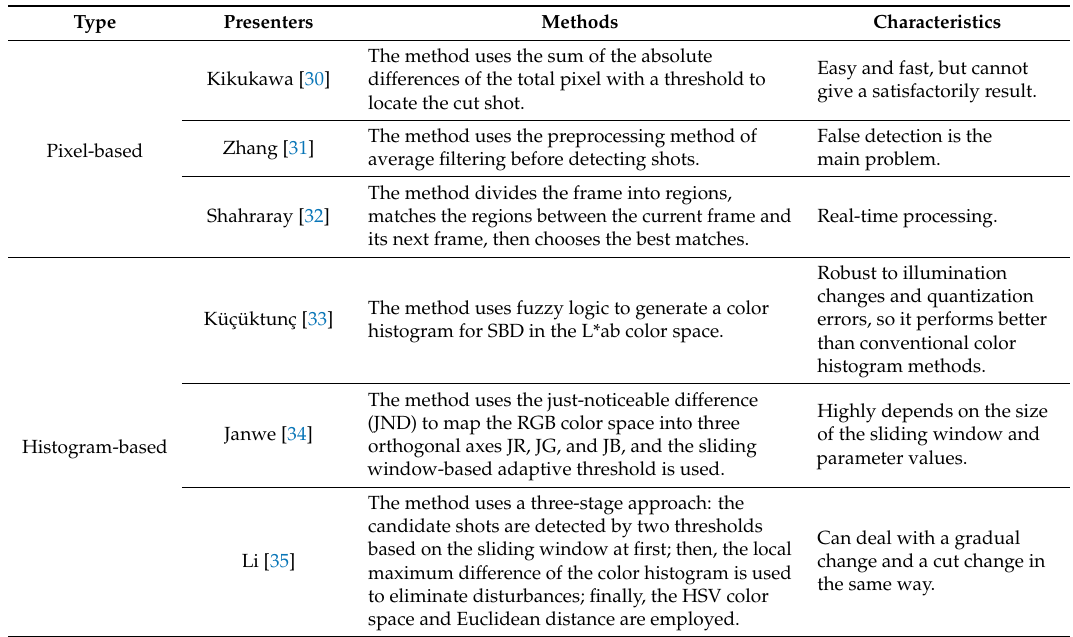
Table 3. Description of the SBD